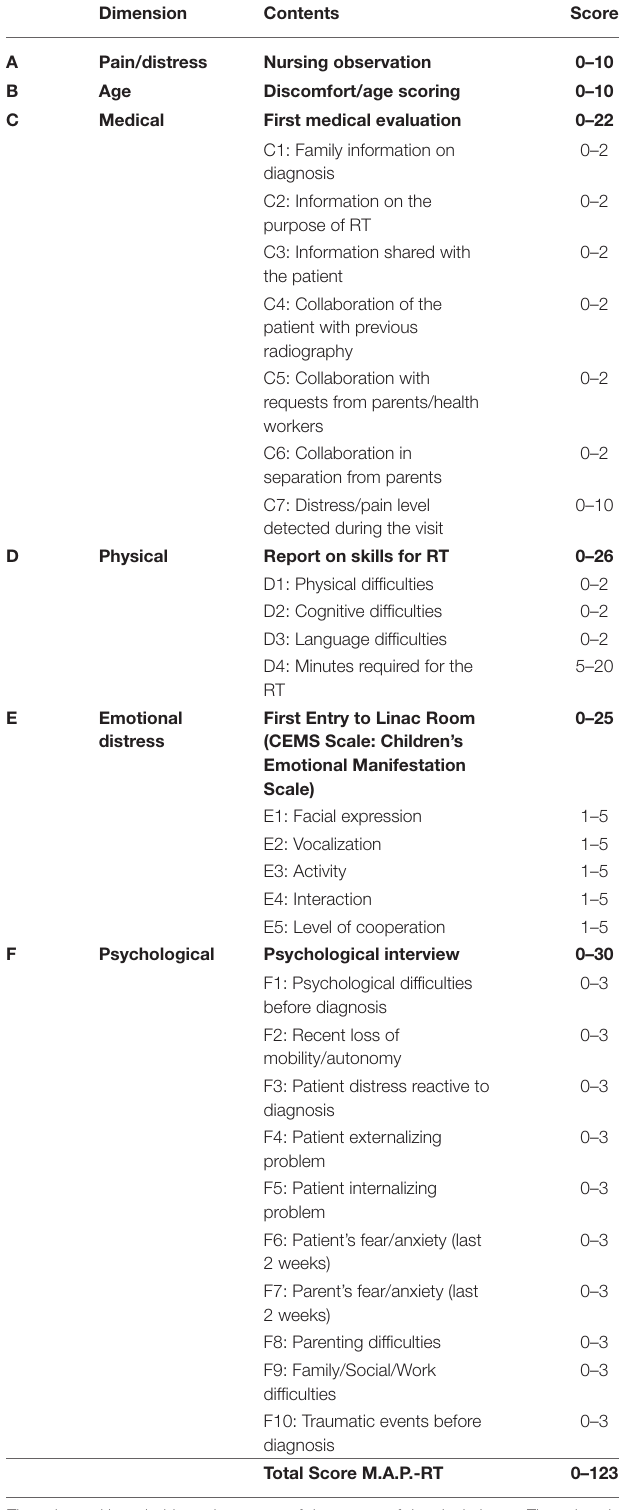
TABLE 1 | M.A.P.-RT scoring and items